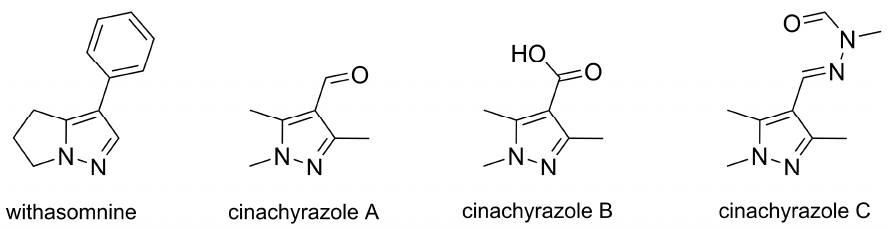
Figure 2. Structures of withasomnine and cinachyrazoles A, B, and C, pyrazole alkaloids occurring in plants and sea sponges.